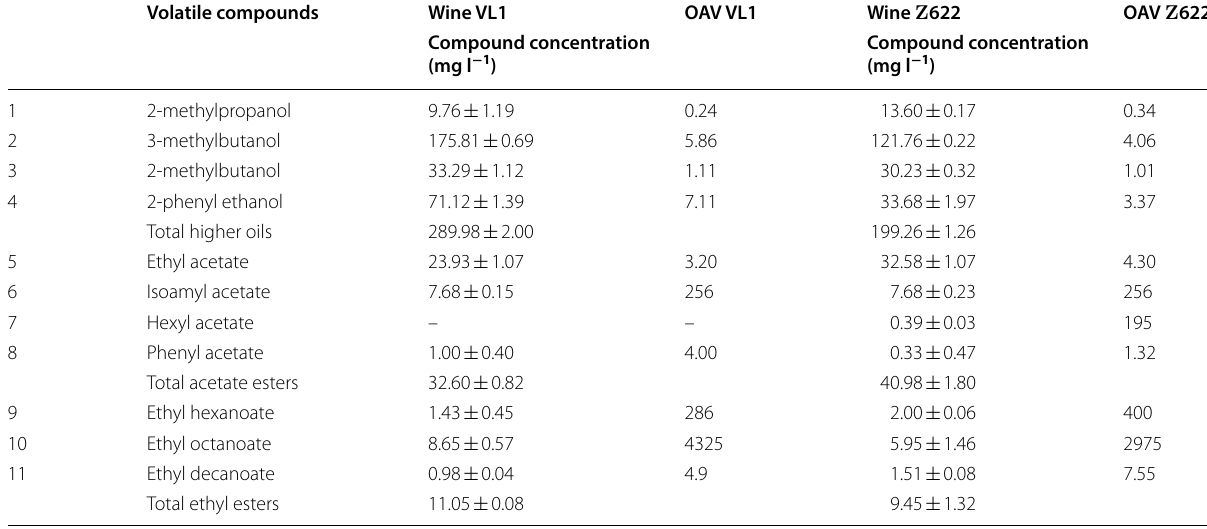
OAV odour activity value estimated according to Molina et al.